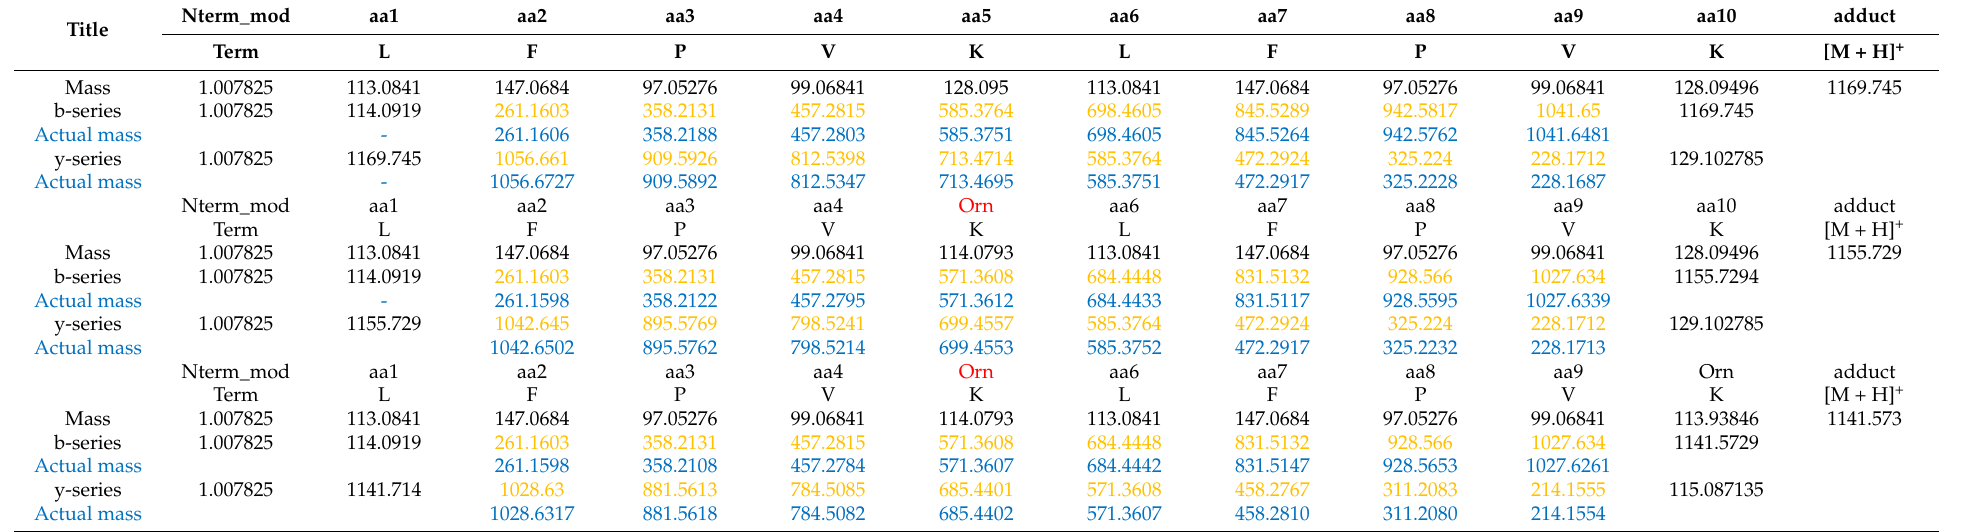
Table 2. Nagano gramicidins’ mass spectrometric peptide fragmentation. For GS-1141, GS-1155, and GS-1169, where ( (cid:4) ) represents the presence of each fragment, ( (cid:4) ) represents the absence and ( (cid:4) ) represents the actual